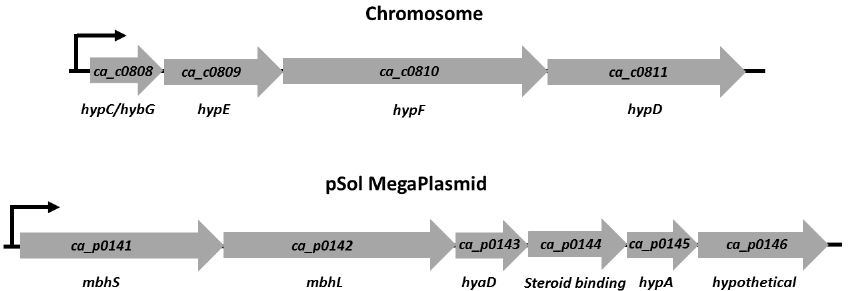
Figure 1. Genetic maps of [NiFe]-hydrogenase subunit and maturation factor operons. Black arrows denote transcriptional start sites for operons indicated by DOOR 2 and Rockhopper using RNA-Seq data (Figure S2) [22,28]. One operon is located on the chromosome and includes genes for maturation factors HypC/HybG, HypE, HypF, and HypD; annotated ca_c0808 , ca_c0809 , ca_c0810 , and ca_c0811 , respectively. The second operon is located on the pSol megaplasmid, and it includes genes for the two hydrogenase subunits, the HyaD protease, a putative heme binding protein, possible HypA maturation factor, and a hypothetical truncated HypF like protein; annotated ca_p0141 , ca_p0142 , ca_p0143 , ca_p0144 , ca_p0145 , and ca_p0146 , respectively.